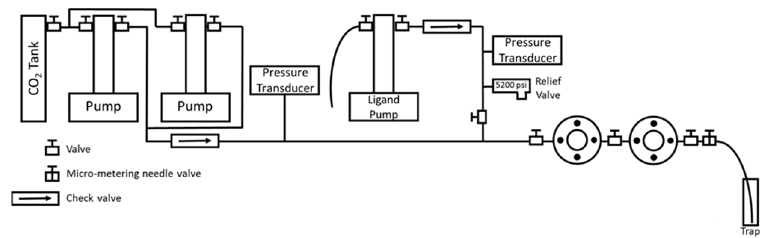
Figure 2. Diagram of the system used for CO 2 extractions.